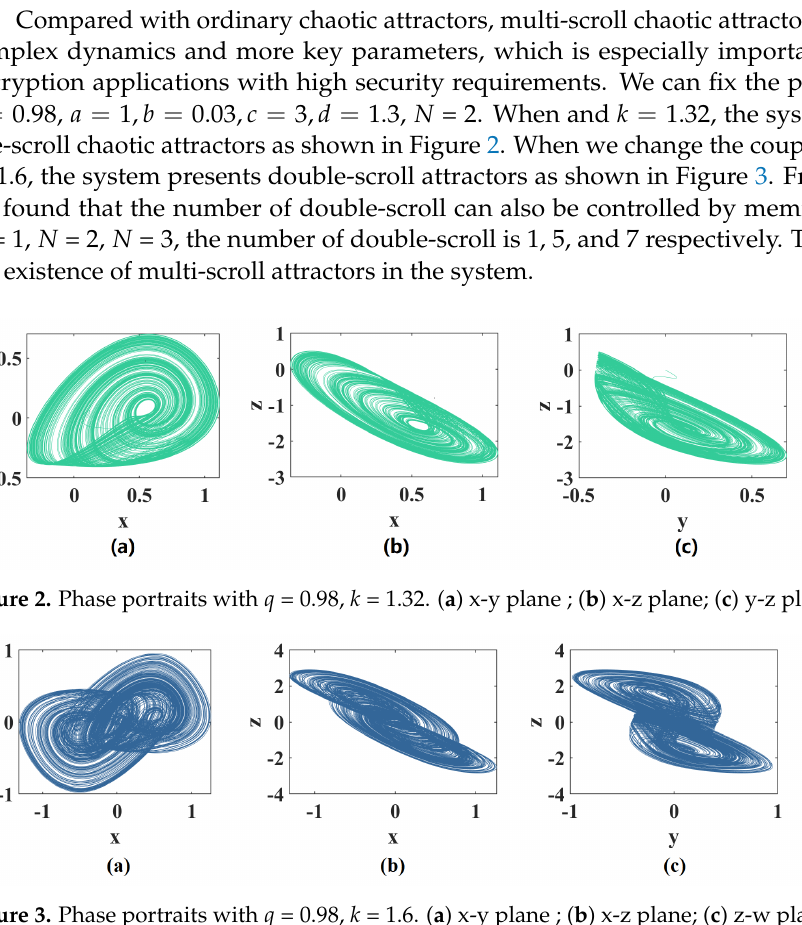
Figure 3. Phase portraits with q = 0.98, k = 1.6. ( a ) x-y plane ; ( b ) x-z plane; ( c ) z-w